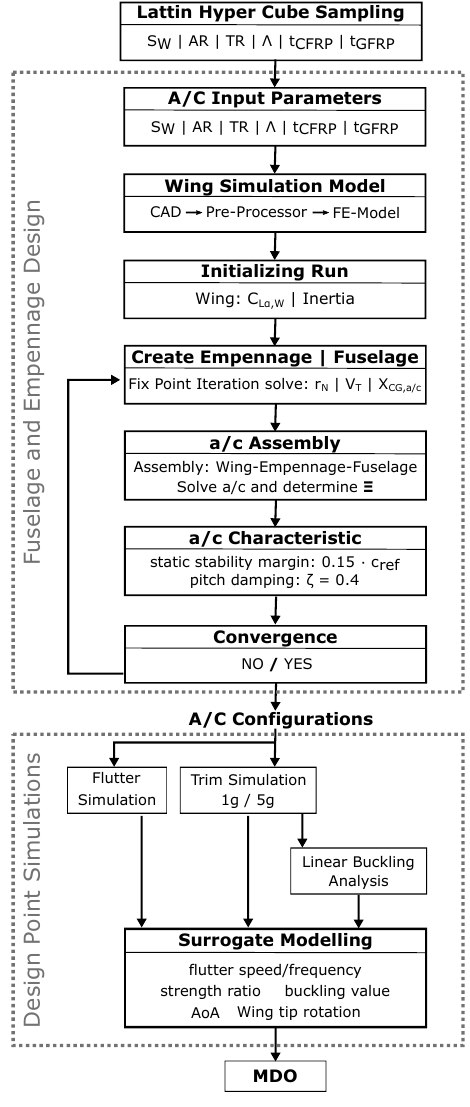
Figure 1. Aircraft design process and design point